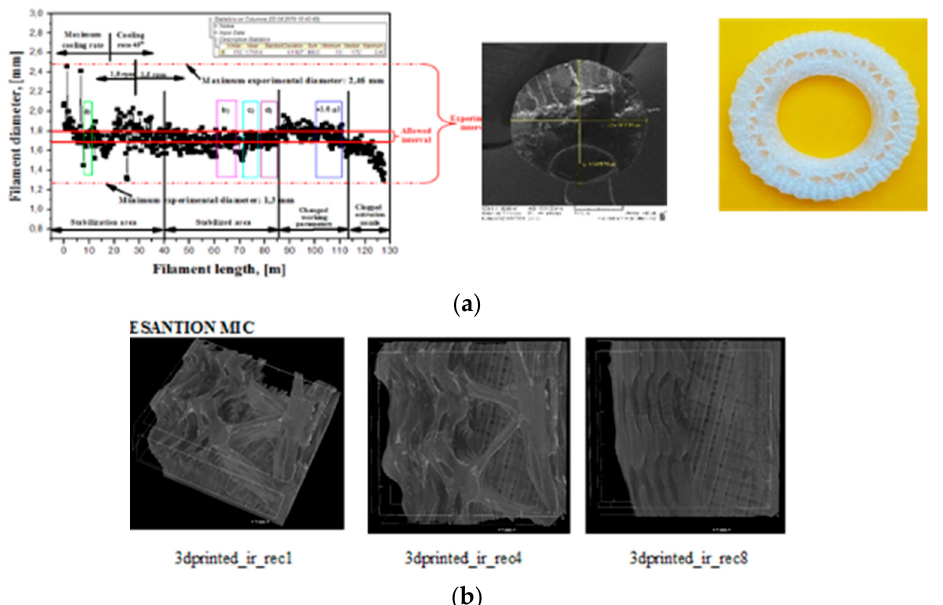
Figure 1. Variation of filament ( a ) diameter obtained from selected material (filament’s ovality) ( b ) 3D-printed item and morphology of the 3D-printed item visualized by